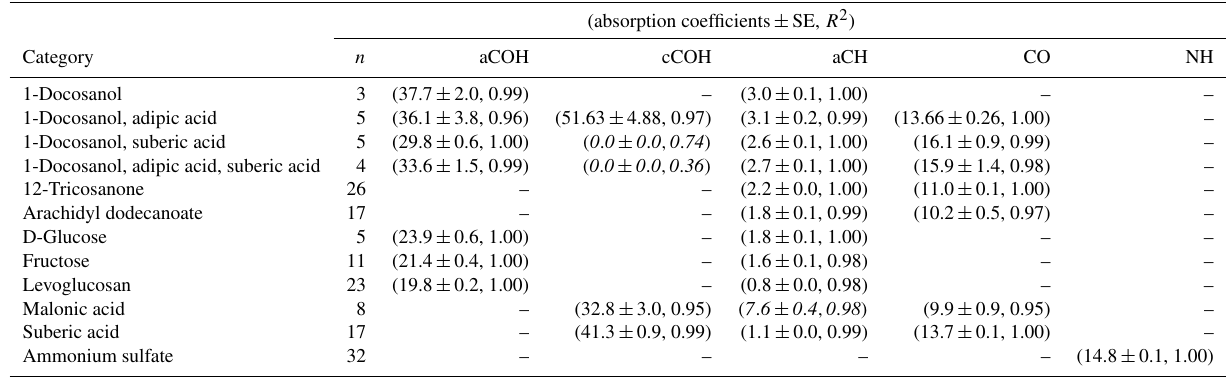
Figure 2. Top row: integrated absorption as a function of known molar abundance used to derive molar absorption coefficients. Bottom row: evaluation of derived absorption coefficients on predicted concentrations for test set compounds not used in the fitting. Table 2. Recalibrated absorption coefficients and fit statistics for each FG and compound. Italicized texts denote the compounds not used in the computation of cCOH and aCH absorption coefficients